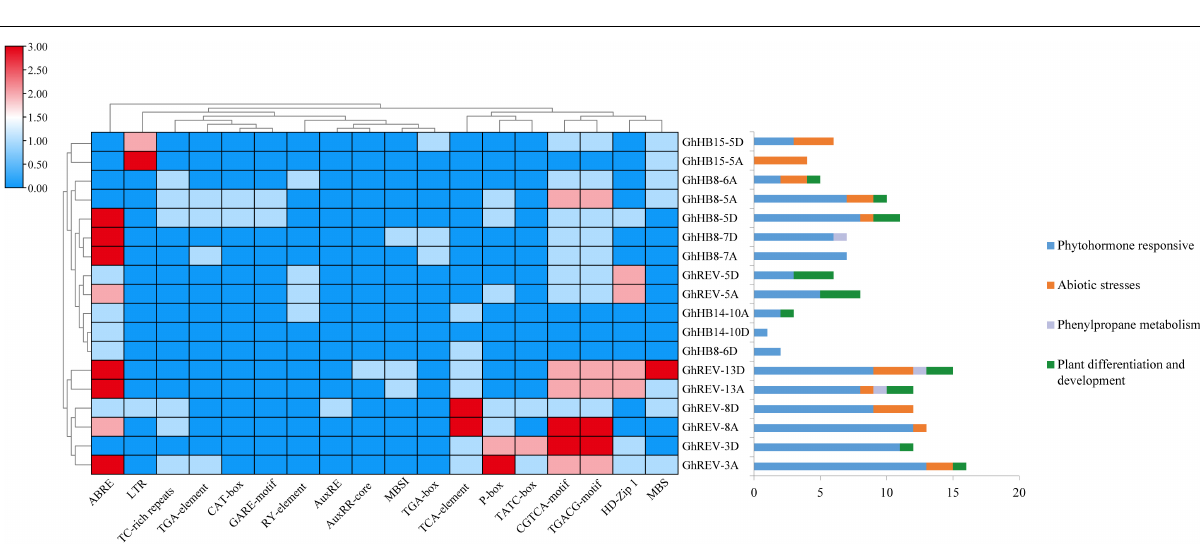
FIGURE 2 | Statistics of cis -elements in the promoter region of cotton ( Gossypium hirsutum ) HD-ZIP III genes. The left part shows statistics on the number of specific cis -elements contained in each HD-ZIP III gene promoter region. The right part exhibits statistics on the function of cis -elements possessed in each HD-ZIP III gene promoter